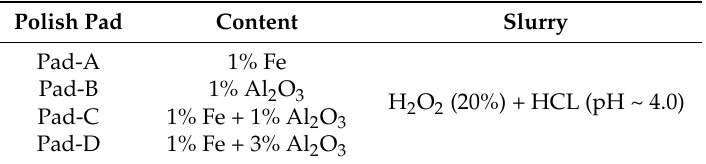
Figure 1. Images of polishing pads impregnated with Fe and Al 2 O 3 particles at various concentrations: ( a ) 1 wt % Fe particles; ( b ) 1 wt % Al 2 O 3 particles; ( c ) 1 wt % Fe and 1 wt % Al 2 O 3 particles; and ( d ) 1 wt % Fe particles and 3 wt % Al 2 O 3 particles. Table 1. Nanoparticle impregnated pads.